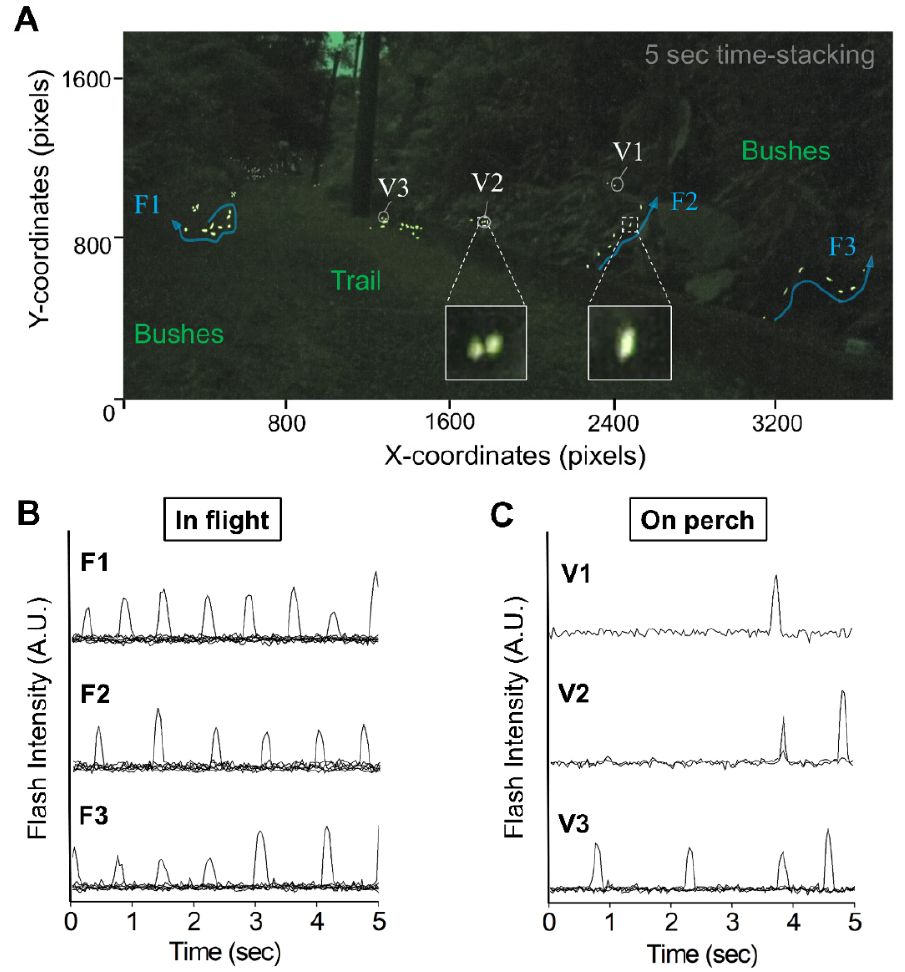
Figure 1. Distinguishing the flash patterns during flight and perching in an A. cerata habitat. ( A ) A time-stacking (5 s) graph displays flash activities along the Genliao hiking trail after sunset. Flying individuals (F1–F3) display discrete flash trajectories (blue arrow lines) composed of oblong-shaped flashes (right inner panel). Those perching (V1–V3) exhibit flash clusters (white hollow circles) composed of round-shaped spots (left inner panel). The graph in RGB mode was converted from a 5 s video clip with 30 fps at 18:45 on 21 April 2018. X–Y scales on the left and bottom of the graph denote pixel units. ( B , C ) Timing diagrams of flash patterns while flying (F1–F3) and perching (V1–V3). Each diagram comprises a single profile or merged profiles of time-series flash spots’ intensity. A.U: Arbitrary unit. Environmental conditions: Temperature: 22.5 ◦ C; Relative humidity: